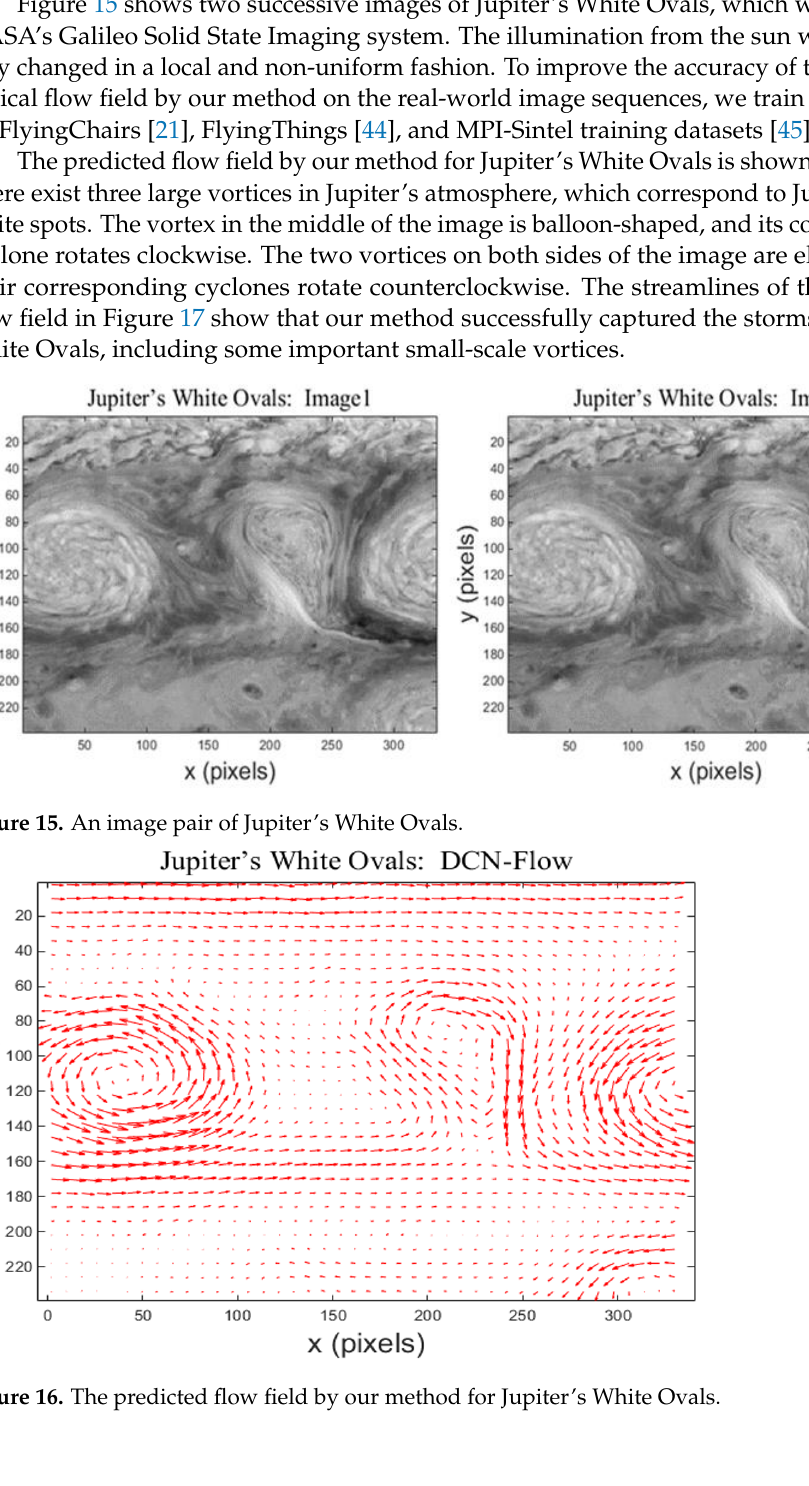
Figure 16. The predicted flow field by our method for Jupiter’s White Ovals.